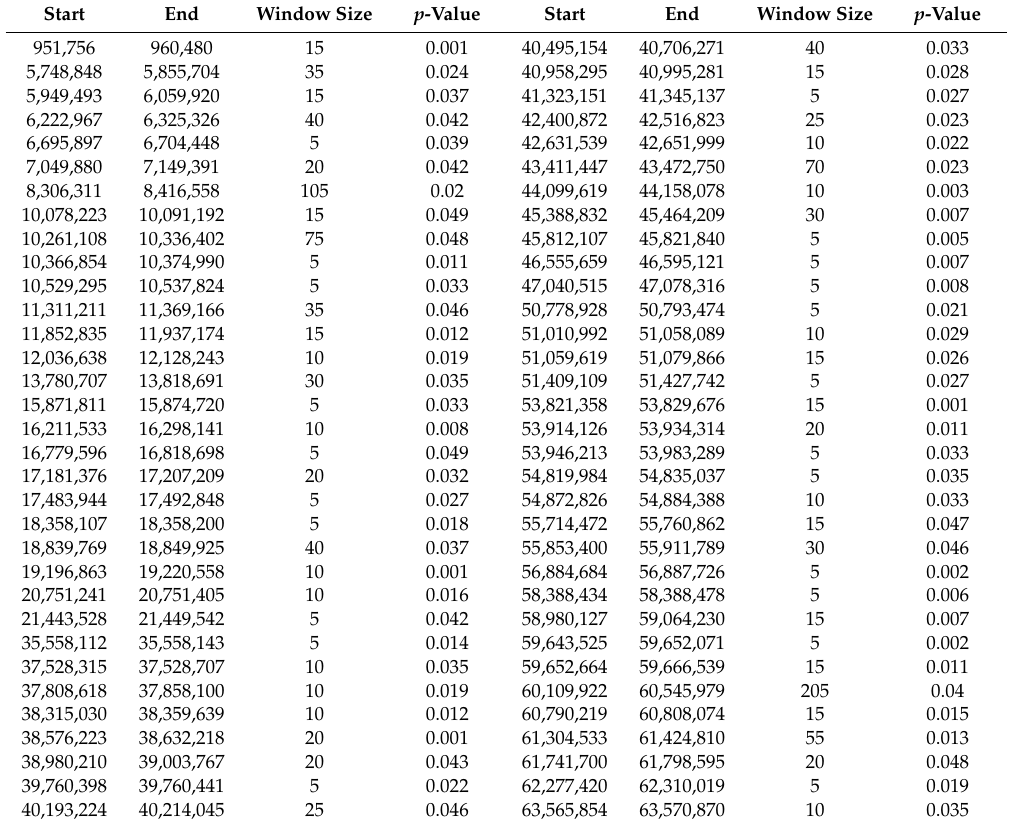
Table 2. Results of SSM for CLL data on Chromosome 19; (Start: the starting nucleotide position of the SSM; End: the ending nucleotide position of the